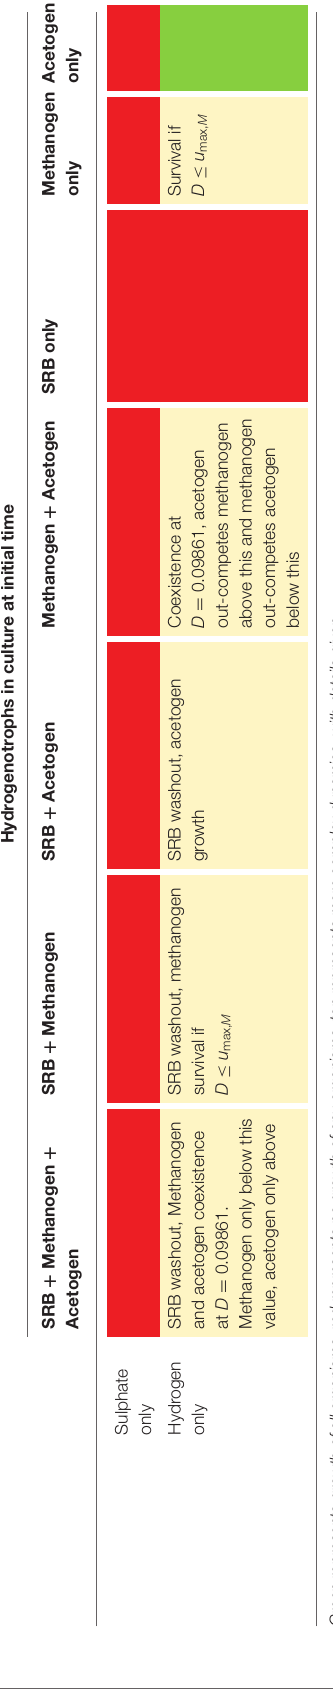
Table 3 outlines the outcomes of all possible